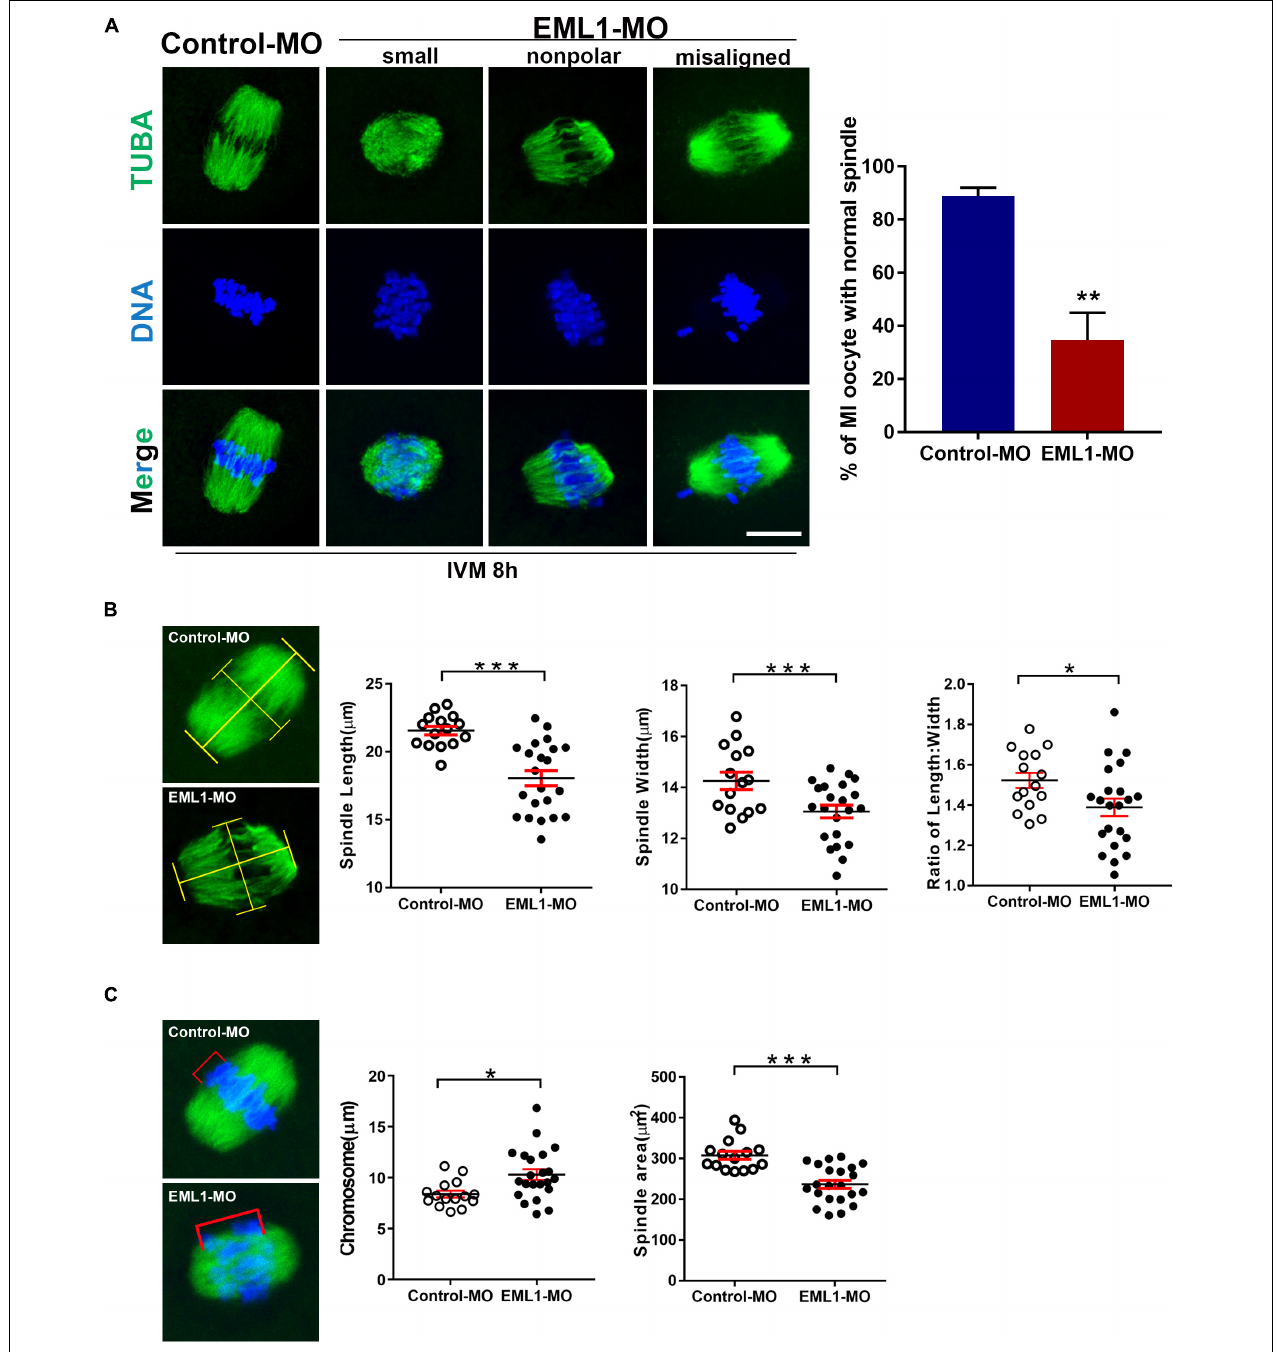
FIGURE 4 | Knockdown of EML1 in oocytes impairs MI- spindle assembly and chromosome alignment. (A) Oocytes microinjected with the MOs were first maintained at GV-stage in milrinone-containing for 24 h, and then transferred to milrinone-free medium for IVM. After 8-h IVM, the oocytes were subjected to IF staining of spindles and chromosomes. The left panel is the representative micrographs of the IF staining, with the α -tubulin and chromosomes stained in green and blue, respectively. Arrows point to misaligned chromosomes. Scale Bar = 20 µ m. The right bar graph shows the quantification of the percentage of the oocyte with normal spindles as revealed by the IF analysis. ** P < 0.01, compared with the Control-MO group. (B) Geometric analysis of the MI- spindles in oocytes that were treated with Control-MO and EML1-MO and EML1-MO. Spindle (stained in green) length and width were measured as illustrated in the left micrographs, and plotted into dot graphs as shown in the right panels. * P < 0.05, *** P < 0.005. (C) Geometric analysis of chromosome alignment in MI- oocytes that were treated with Control-MO and EML1-MO. Chromosome displacement was measured according to the illustration in the left panel, and the quantification was shown in the right graph. The spindle was shown in green and chromosomes in blue. * P < 0.05, *** P < 0.005.